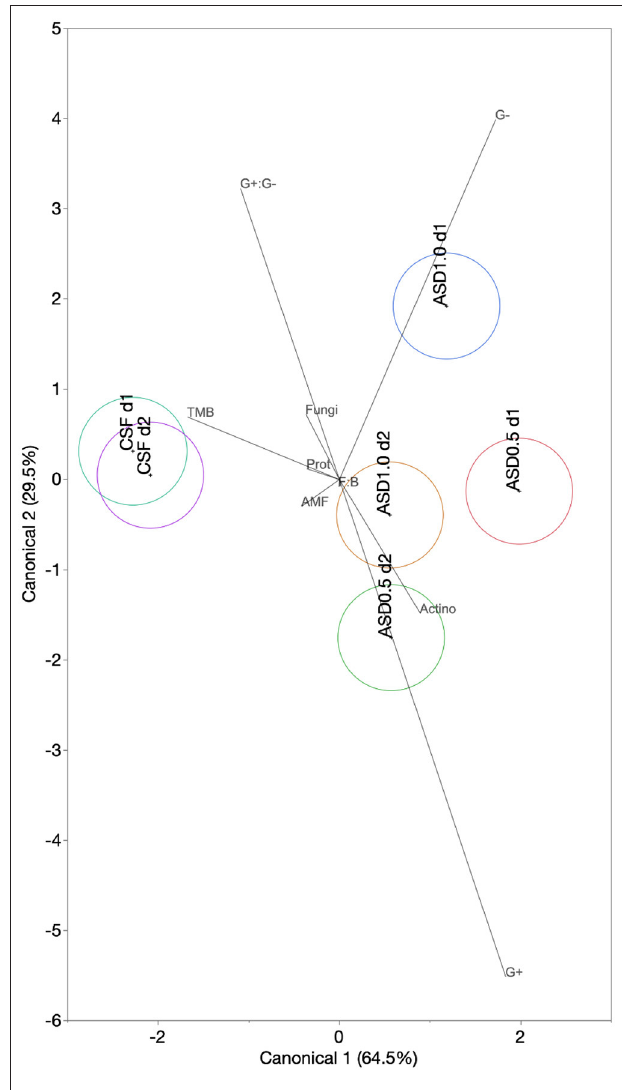
FIGURE 3 | Canonical discriminant analysis of PLFA biomarkers for the two-way interaction of soil treatment and soil depth across sampling dates. Vectors represent standardized canonical coefficients and indicate the relative contribution of each biomarker group to each canonical variate. Ellipses represent 95% confidence region of the mean. CSF, chemical soil fumigation control with Pic-Clor 60 at a rate of 224kg ha − 1 ; ASD0.5, anaerobic soil disinfestation with 6.9 m 3 ha − 1 of molasses and 11 Mg ha − 1 of composted poultry litter; ASD1.0, anaerobic soil disinfestation with 13.9 m 3 ha − 1 of molasses and 22 Mg ha − 1 of composted poultry litter. G + :G − , ratio of Gram positive bacteria to Gram negative bacteria; F:B, ratio of fungi:bacteria; TMB, total microbial biomass; G + , Gram positive bacteria; Prot, protozoa; G − , Gram negative bacteria; Actino, actinomycetes; AMF, arbuscular mycorrhizal fungi; ASD0.5 d1, ASD0.5 at 0–15cm soil depth; ASD0.5 d2, ASD0.5 at 15–30cm soil depth; ASD1.0 d1, ASD1.0 at 0–15cm soil depth; ASD1.0 d2, ASD1.0 at 15–30cm soil depth; CSF d1, chemical soil fumigation control at 0–15cm soil depth; CSF d2, chemical soil fumigation control at 15–30cm soil